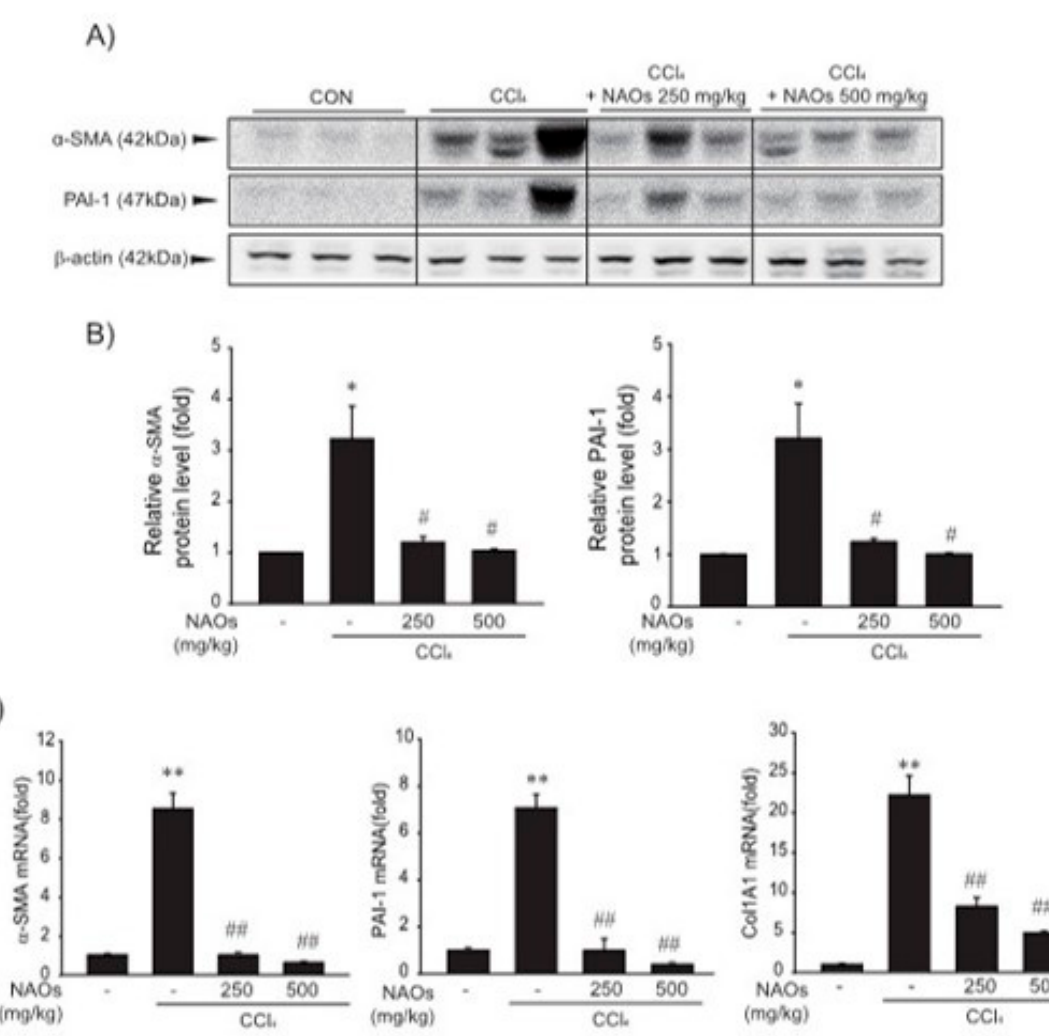
Table 1. Histomorphometrical analysis of hepatic tissues from vehicle or CCl4-treated mice.